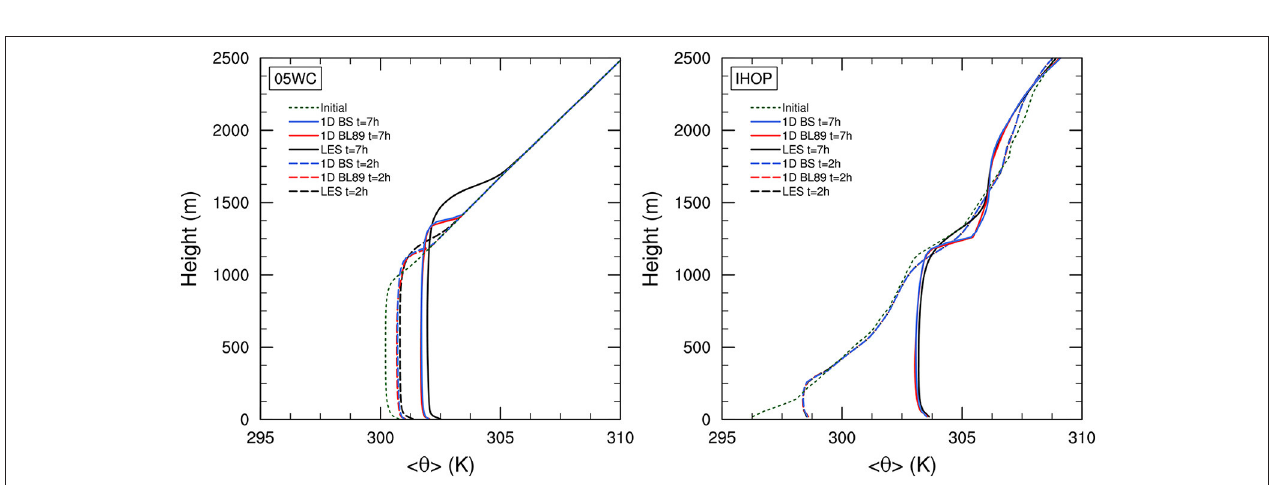
FIGURE 10 | Potential temperature profiles for the convective cases with strong shear 05WC (Left) and weak shear IHOP (Right) ; see Table 1 . Three runs are compared: the LES (black), the SCM with the BL89 length (red), and the SCM with the BS length (blue). Profiles are plotted 2 h (dashed line) and 7 h (solid line) after the start of the simulation (dotted